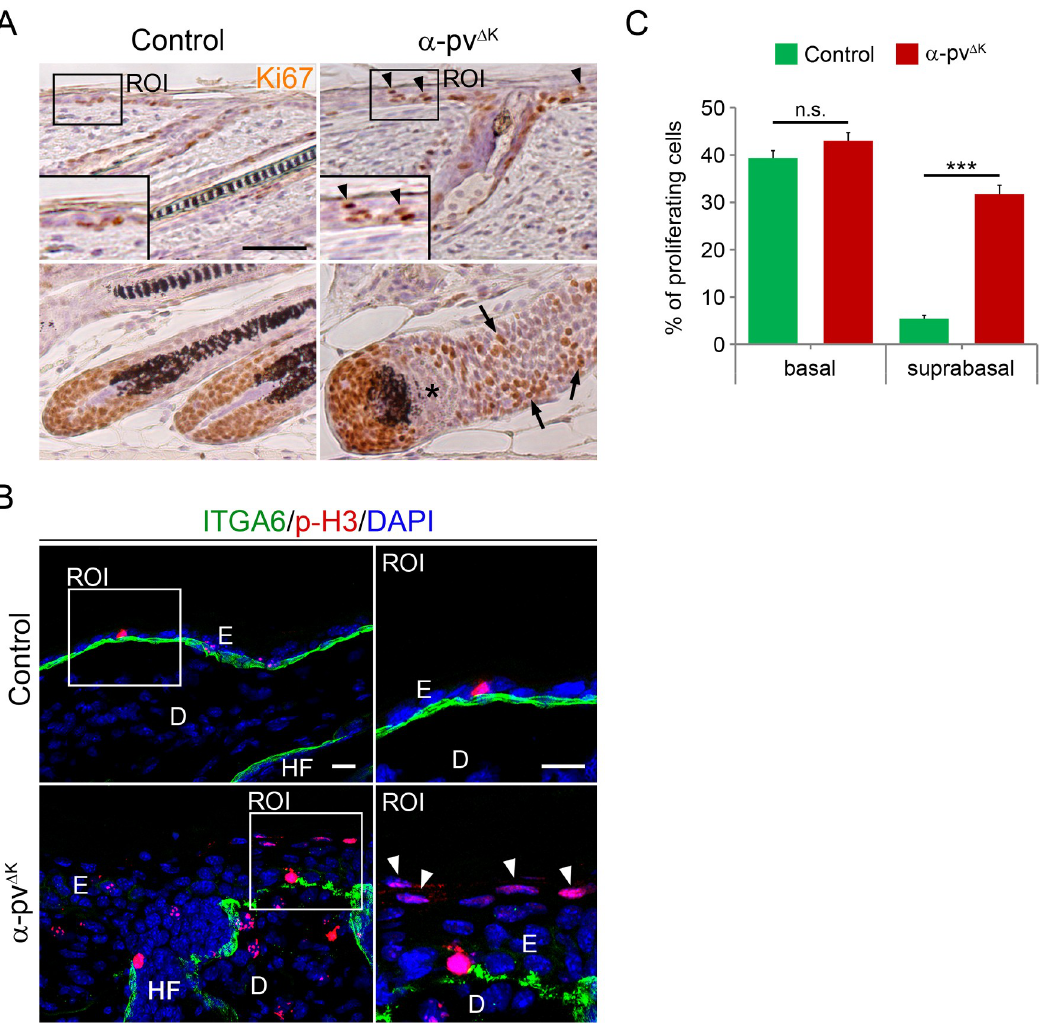
Fig 3. Deletion of α -pv results in the accumulation of ectopically proliferating cells in suprabasal layers of the epidermis and in the ORS. ( A ) Ki67 staining of control and α -pv Δ K skin sections. Arrowheads indicate proliferating suprabasal cells and arrow point to proliferative cells in the ORS of α -pv-null HFs. Asterisks indicate a region in the α -pv Δ K HF-bulb devoid of proliferative cells. Scale bar: 50 μ m. ( B ) Double-fluorescent labeling for phospho-histone 3 and α 6-integrin of control and α -pv Δ K skin sections. Nuclei were visualized with DAPI. Arrowheads indicate proliferating suprabasal cells. Scale bar: 20 μ m. E: epidermis, D: dermis and HF: hair follicles ( C ) Quantification of Ki67-positive cells in basal and suprabasal layers of control and α -pv Δ K epidermis. Values represent